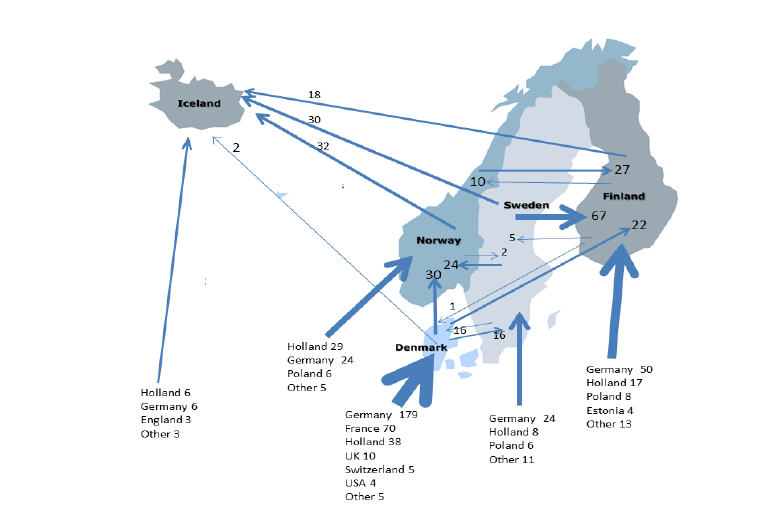
Fig. 2. Illustration of number of cultivars from other countries that are listed in a respective Nordic country based on information from the last national variety list in the country. Included in the numbers are all crops used as food and agriculture minus fruit and